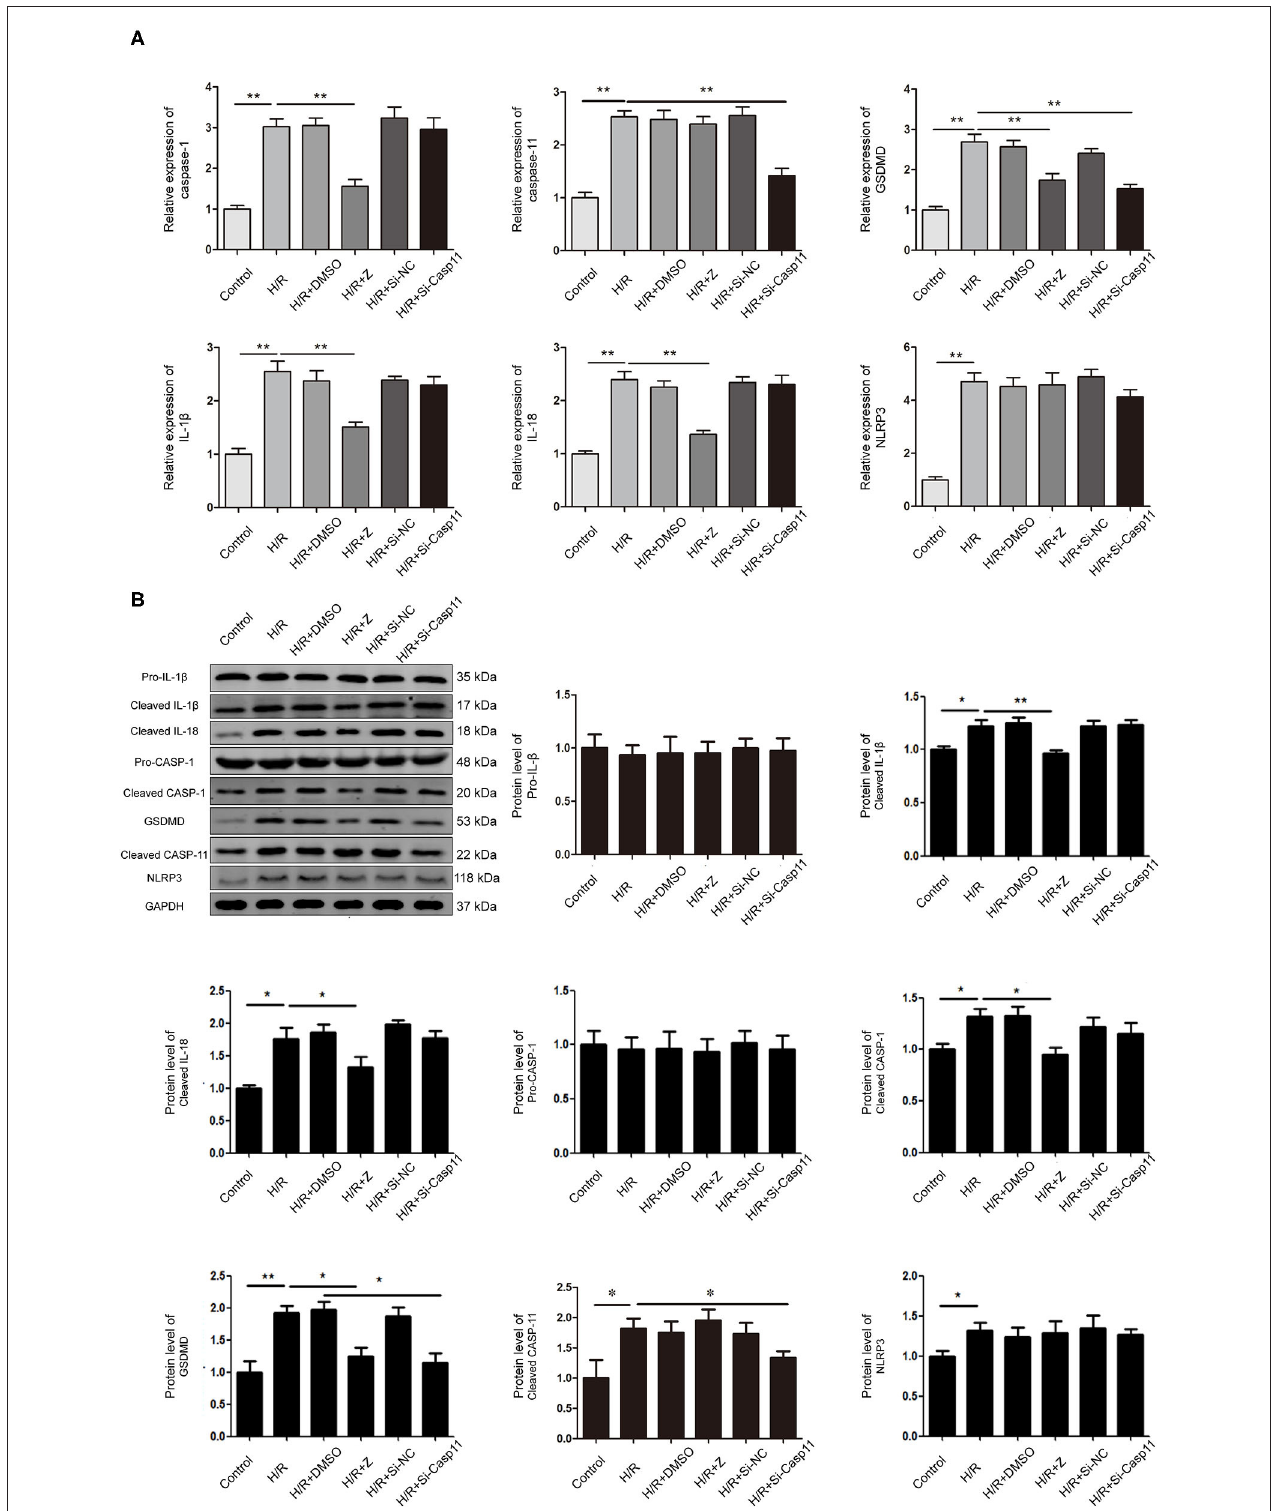
FIGURE 6 | Effect of Z-YVAD-FMK and si-caspase-11 on protein and mRNA expression in the NRK-52E cell culture model. (A) mRNA levels of NLRP3, caspase-1, caspase-11, GSDMD, IL-1 β , and IL-18 in NRK-52E cells after H/R. (B) Protein expression and statistical analysis of NLRP3, pro-caspase-1, cleaved-caspase-1, cleaved-caspase-11, GSDMD, pro-IL-1 β , cleaved-IL-1 β and cleaved-IL-18 in NRK-52E cells after caspase-1 or caspase-11 inhibition. * p < 0.05, ** p < 0.01. Z = Z-YVAD-FMK; H/R, hypoxia/reoxygenation; DMSO, dimethyl sulfoxide; Si-casp11, small interfering ribonucleic acid caspase-11; Si-NC, si-caspase-11 negative control; GSDMD, gasdermin D; GAPDH, glyceraldehyde-3-phosphate dehydrogenase.